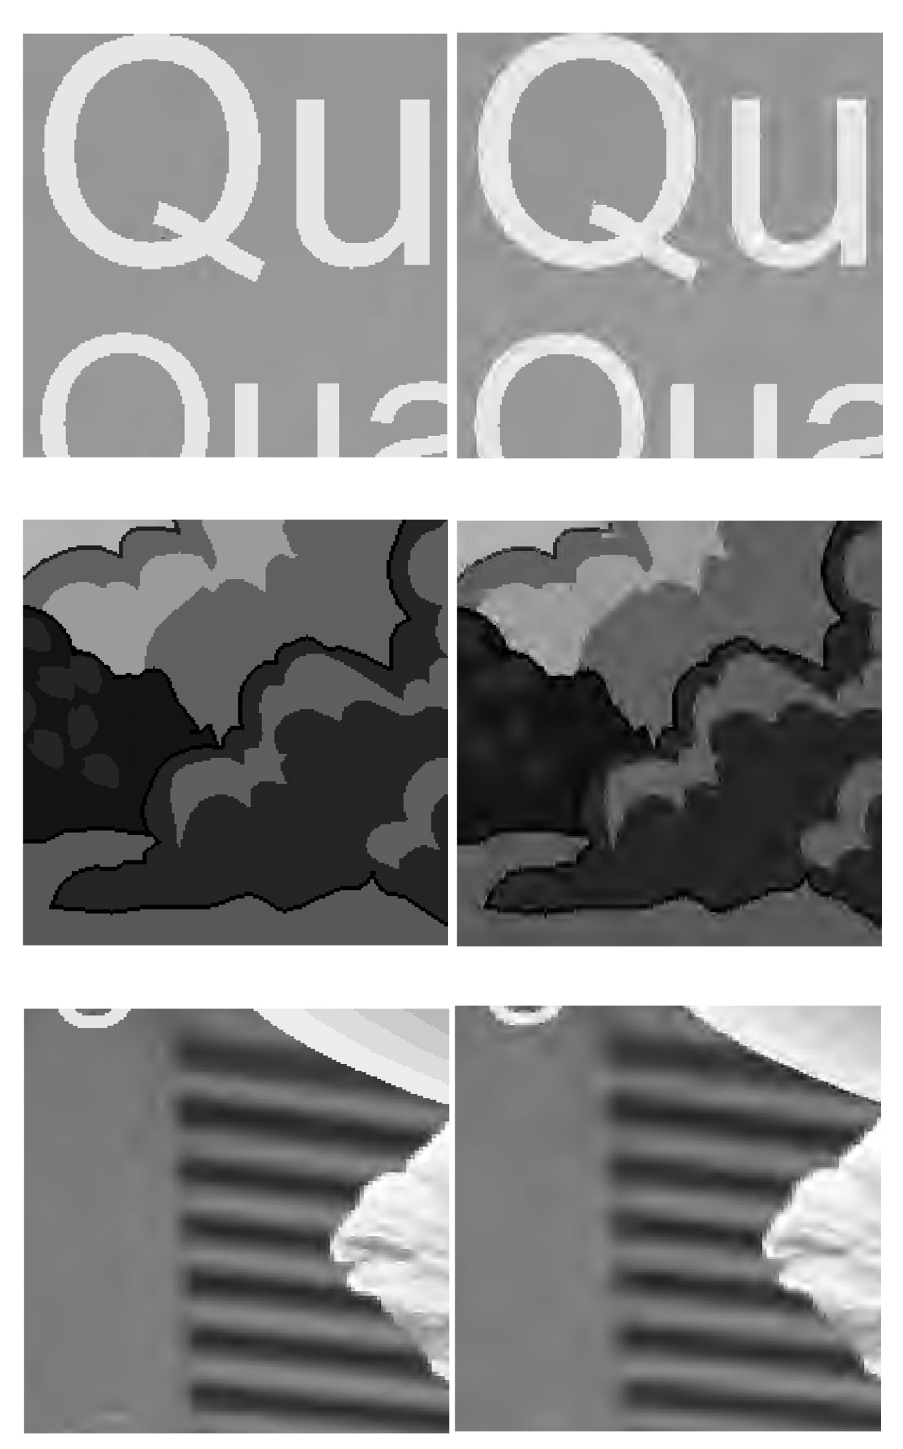
Figure 5: Comparison of portions of decoded cmpnd2 images by our two-class coder at 0.133 bpp, PSNR = 37.45 dB (left) and by DjVu coder at 0.138 bpp, PSNR = 29.73 dB